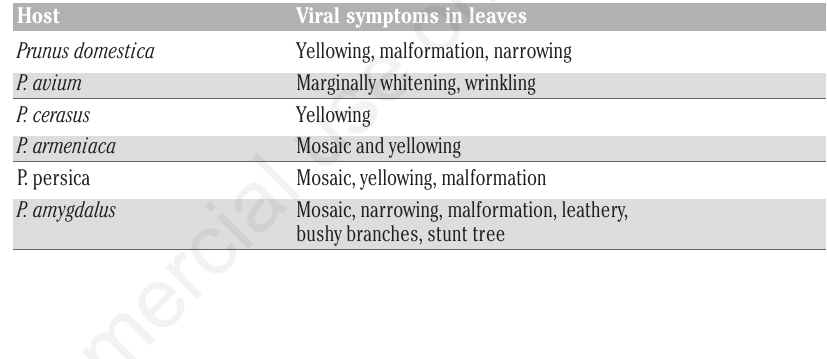
Table 2. Primers designed to detect PDV coat protein.